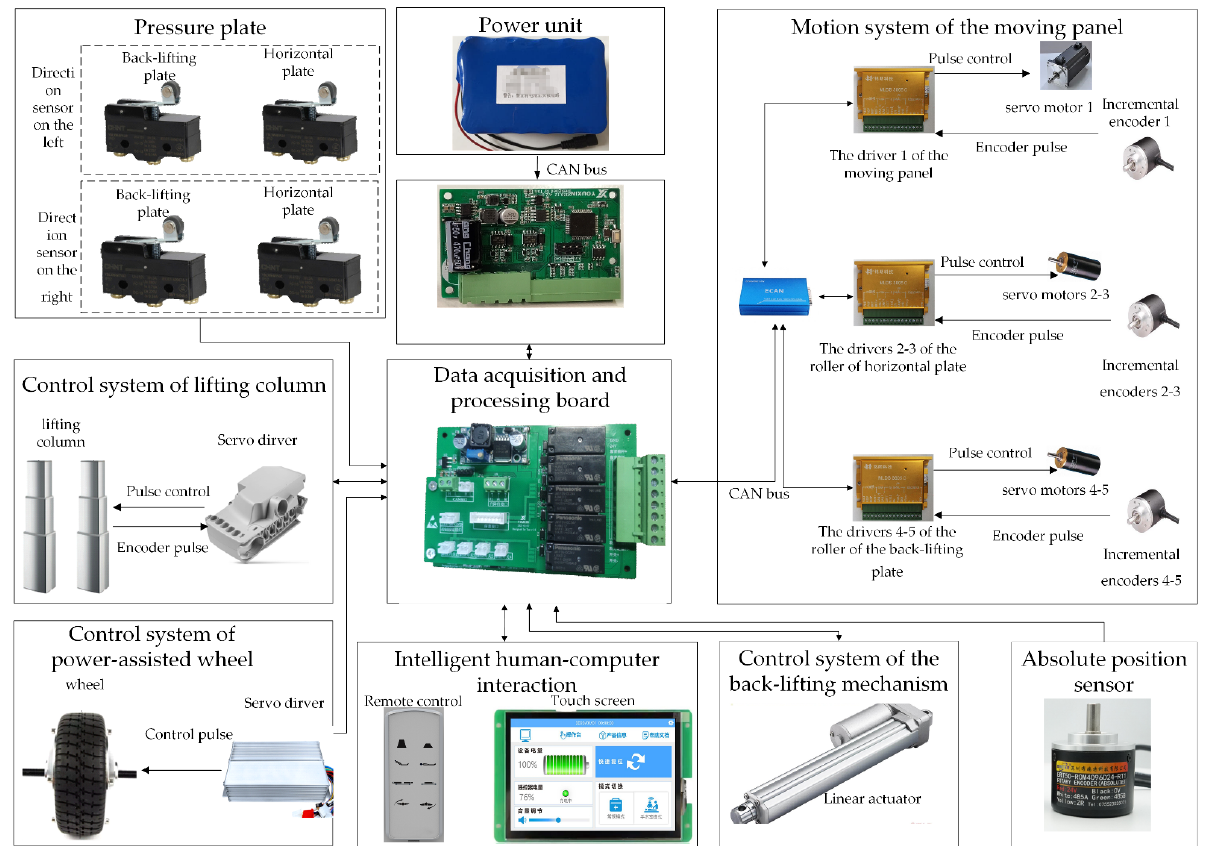
Figure 15. The control system of the patient transfer robot.